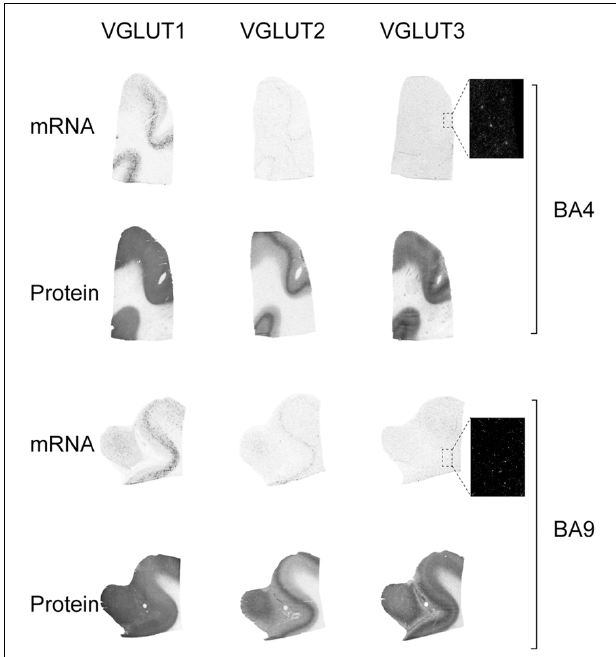
FIGURE 2 | Distribution of VGLUT1-3 mRNA and protein in cerebral cortical Brodmann areas (BA)4 and BA9. Boxed regions are enlarged and shown in